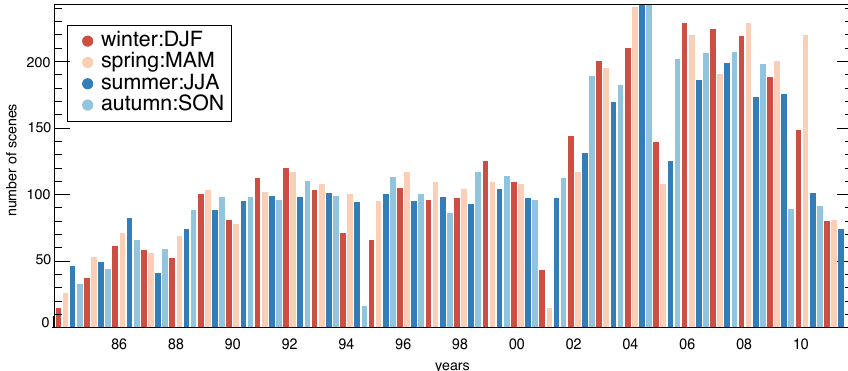
Fig. 2. Archived AVHRR overpasses illustrated by season and number of scenes for the period 1984– 2011.